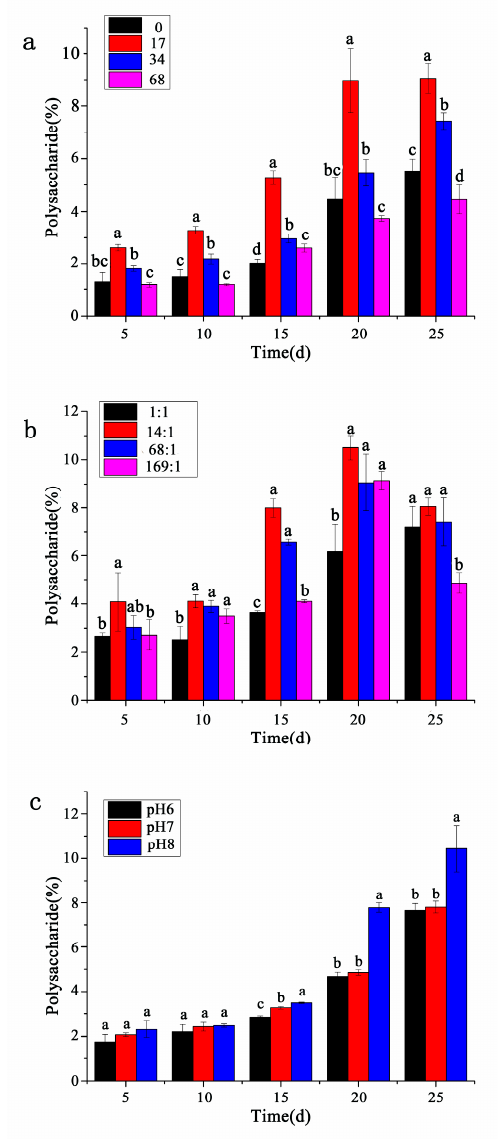
Figure 4. The content of polysaccharides of P. purpureum under different environmental factors. Data were expressed as mean ± standard error. ( a ). P. purpureum polysaccharides content at different salinity. ( b ). P. purpureum polysaccharides content at different nitrogen-to-phosphorus ratios. ( c ). P. purpureum polysaccharides content at different pH conditions.